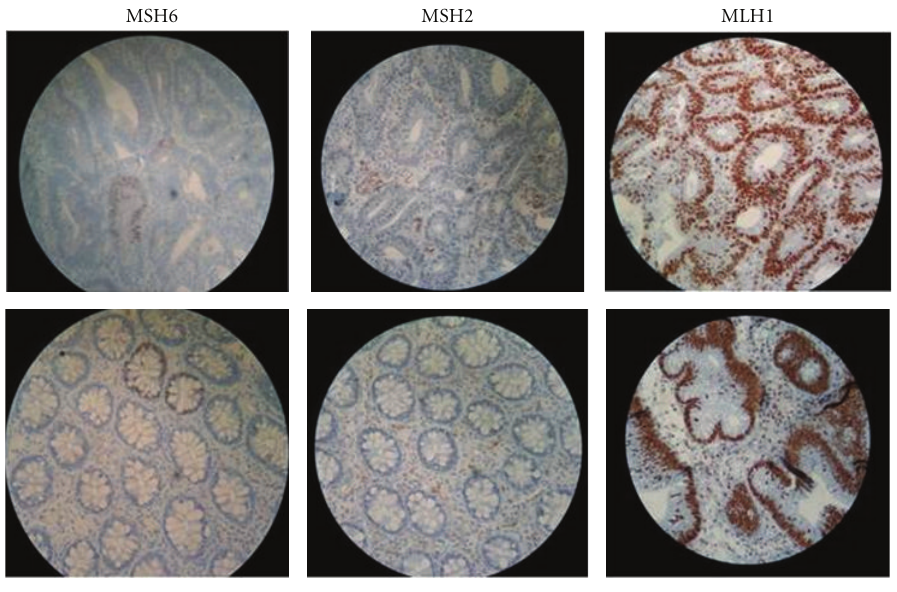
Figure 4: IHC evaluation of complex protein expression MMR. Reactivity was observed in the presence of brown coloration in this case there is not involvement of the MLH1 protein, while exhibiting an alteration in the expression of proteins MSH2 and MSH6 as seen in the images of blue coloration polyp